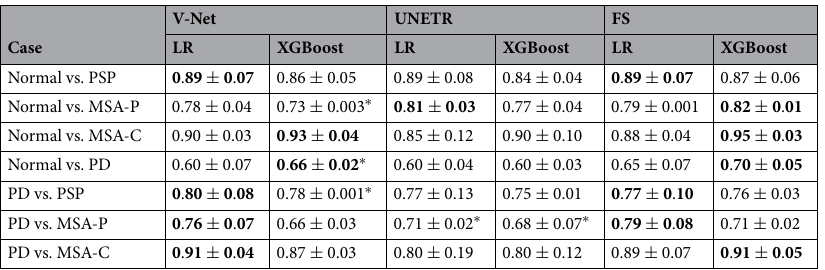
Table 3. Binary classification of diseases based on all the brain structures. AUC in LR and XGBoost of CNN- based V-Net, ViT-based UNETR, and FS. The AUC is expressed as the mean from threefold cross-validation. LR; logistic regression, XGBoost; eXtreme Gradient Boosting. The best result for each volume segmentation method based on FS and DL in each binary classification is shown in bold. * p < 0.05 indicates a significant difference in AUC between the DL models and